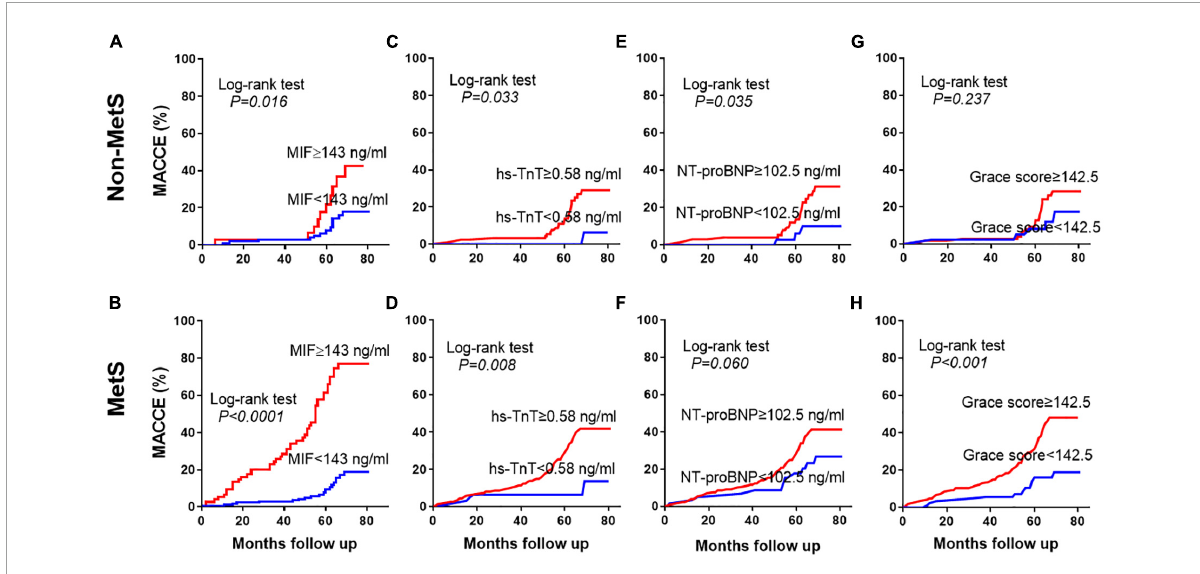
FIGURE4 Prediction of MACCE using different prognostic indicators. Kaplan-Meier curves showing the incidence of MACCEs in the non-MetS and MetS groups during the 4.9-year follow-up period using the cutoff values of admission MIF (A,B) , hs-TnT (C,D) , NT-proBNP (E,F) , and Grace score (G,H) .